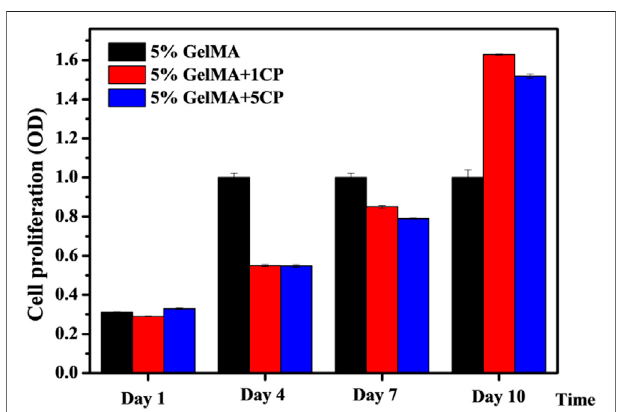
FIGURE4| ProliferationofratBMSCsattachedtothesurfaceofGelMA/ β -TCP hydrogel scaffolds. BMSCs were incubated into hydrogel scaffolds